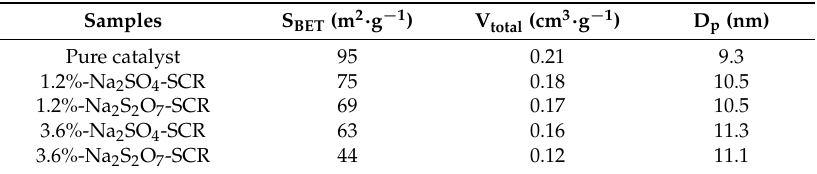
Table 3. Structural characteristics of different Na salts